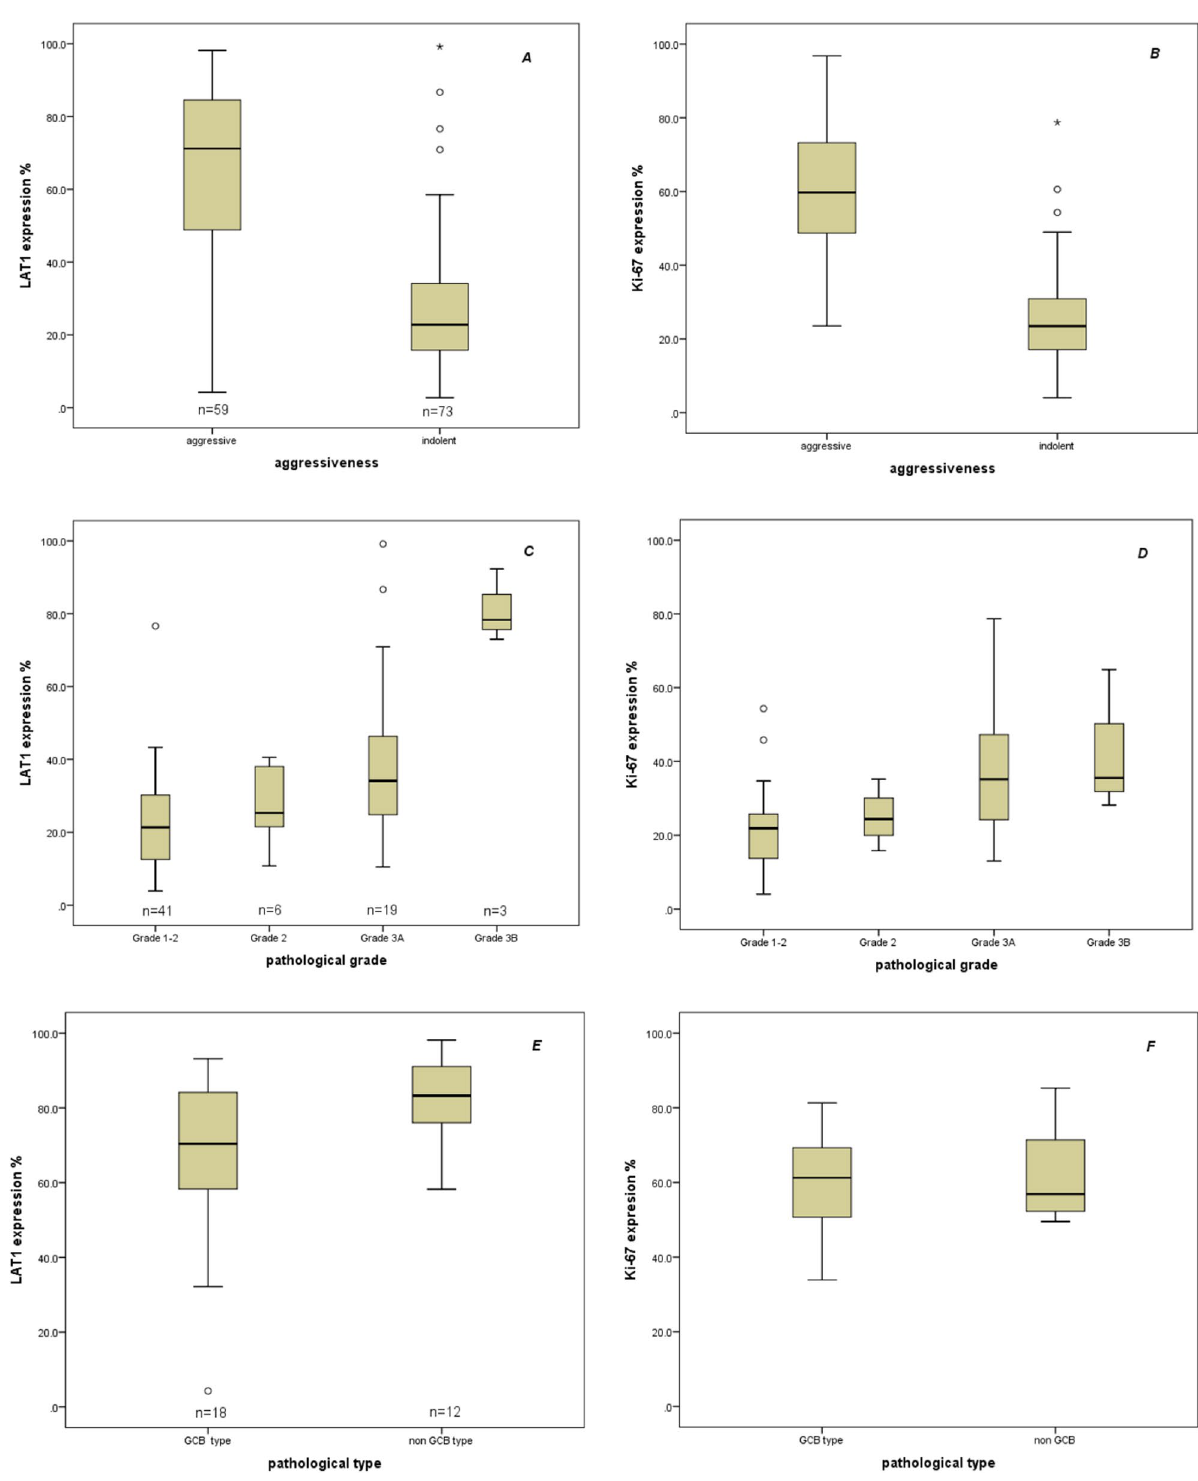
Figure 6. Correlation between expression levels of LAT1 and lymphoma grades. ( A , B ) LAT1 and Ki-67 expression level was significantly different between aggressive types and indolent types of NHL. ( C , D ) Pathological grades of FL were differed by an expression of LAT1 and Ki-67 levels between each other. ( E , F ) LAT1 and Ki-67 expression levels were not significantly different between GCB and non-GCB subtype of